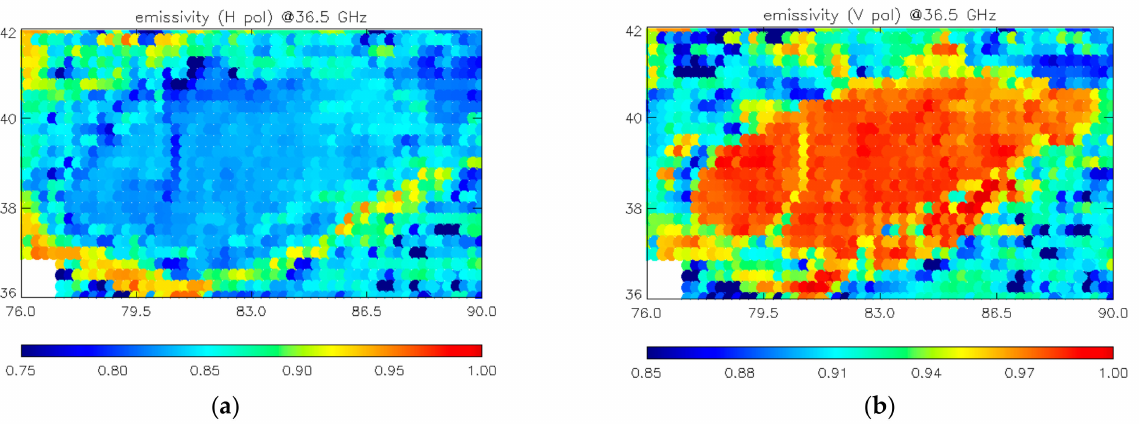
Figure 5. Retrieved emissivity from MWRI at 36.5 GHz on 1–7 August 2017: ( a ) H-pol; ( b )